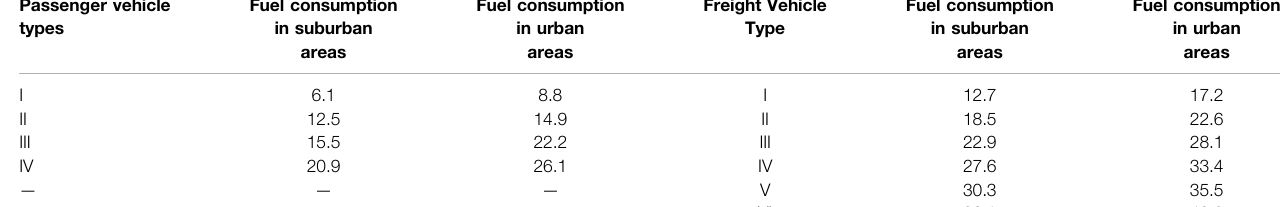
Passenger vehicle types